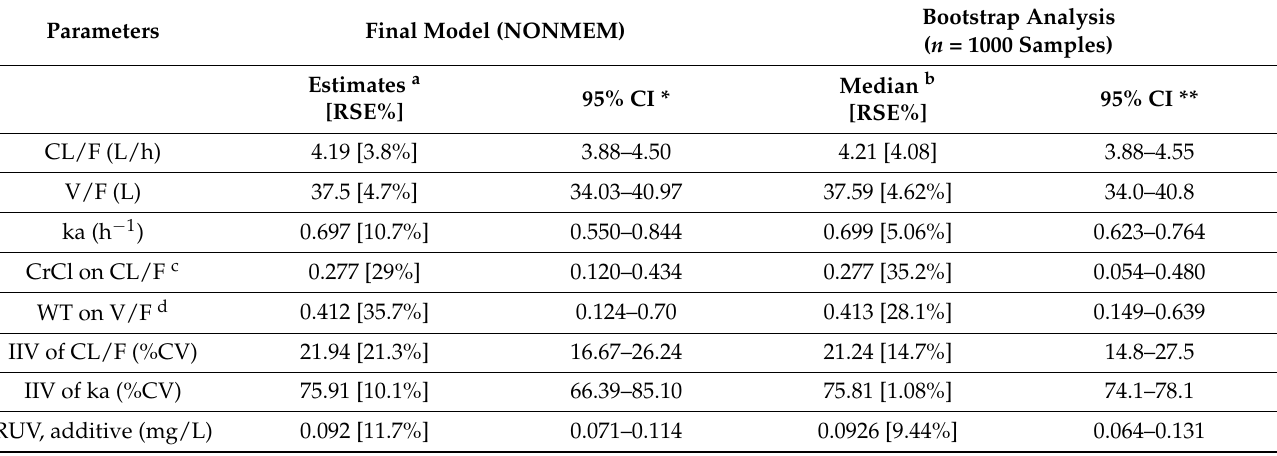
Table 2. Parameter estimates of rivaroxaban in Thai patients with non-valvular atrial fibrillation obtained from the final model and bootstrap